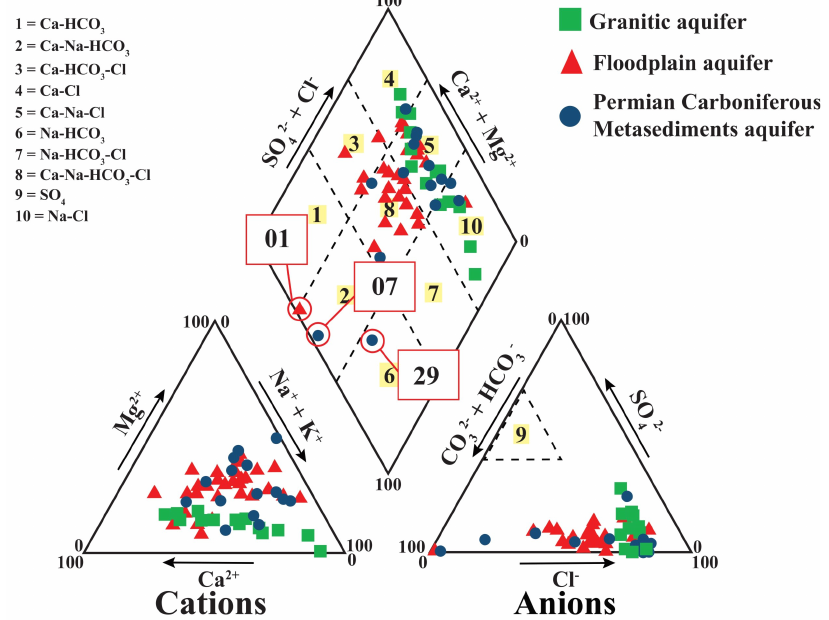
Figure 5. Piper diagram of groundwater in the rainy